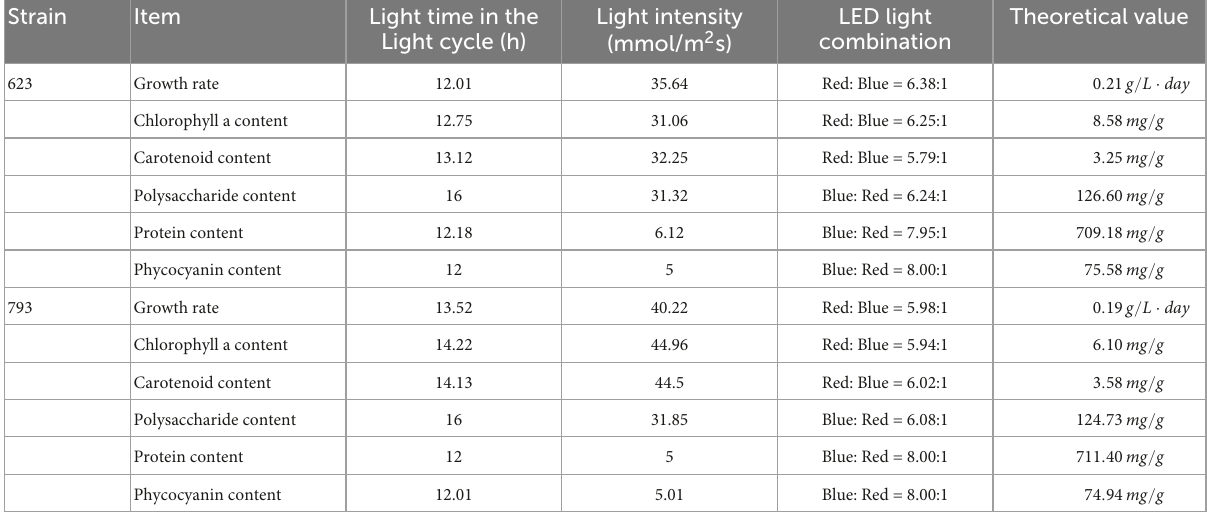
TABLE 8 Theoretical optimal culture scheme for growth rate and organic matter accumulation of Arthrospira platensis OUC623 and A. platensis OUC793. Strain Item Light time in the